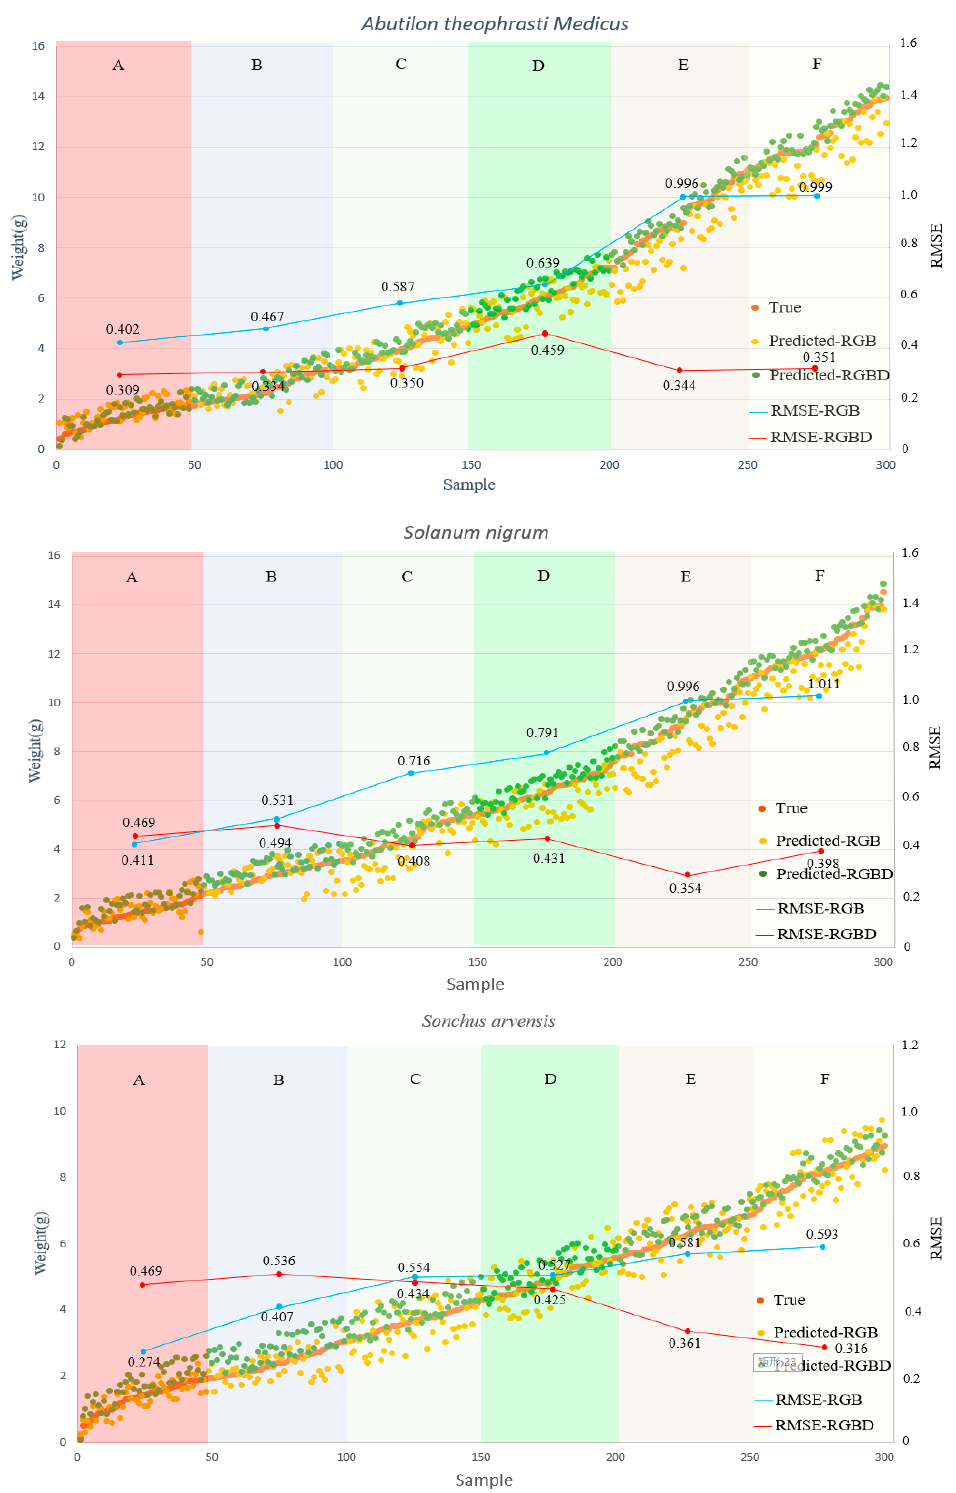
Figure 12. Fitting results for the three weed species. A, B, C, D, E, F represent the six stages of fresh weight on each weed from small to large, and each stage contains 50 weeds. In the scatter chart, True represents the true value of the weeds, the yellow point represents the predicted value using DenseNet201-rgb, and the green point represents the predicted value using DenseNet201-rgbd. In the line chart, the blue point represents the use at this stage The average RMSE value predicted by DenseNet201-rgb. The red dot indicates the average RMSE value predicted by DenseNet201-rgbd at this stage.